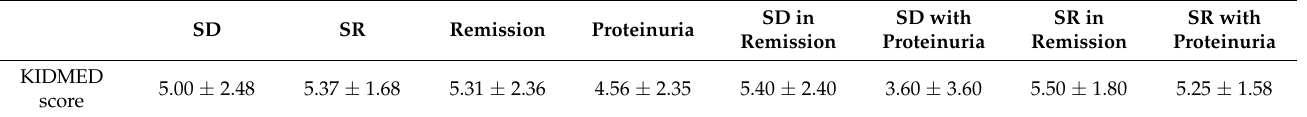
Table 3. Kidmed score values in the clinical groups of Idiopathic nephrotic syndrome (INS).